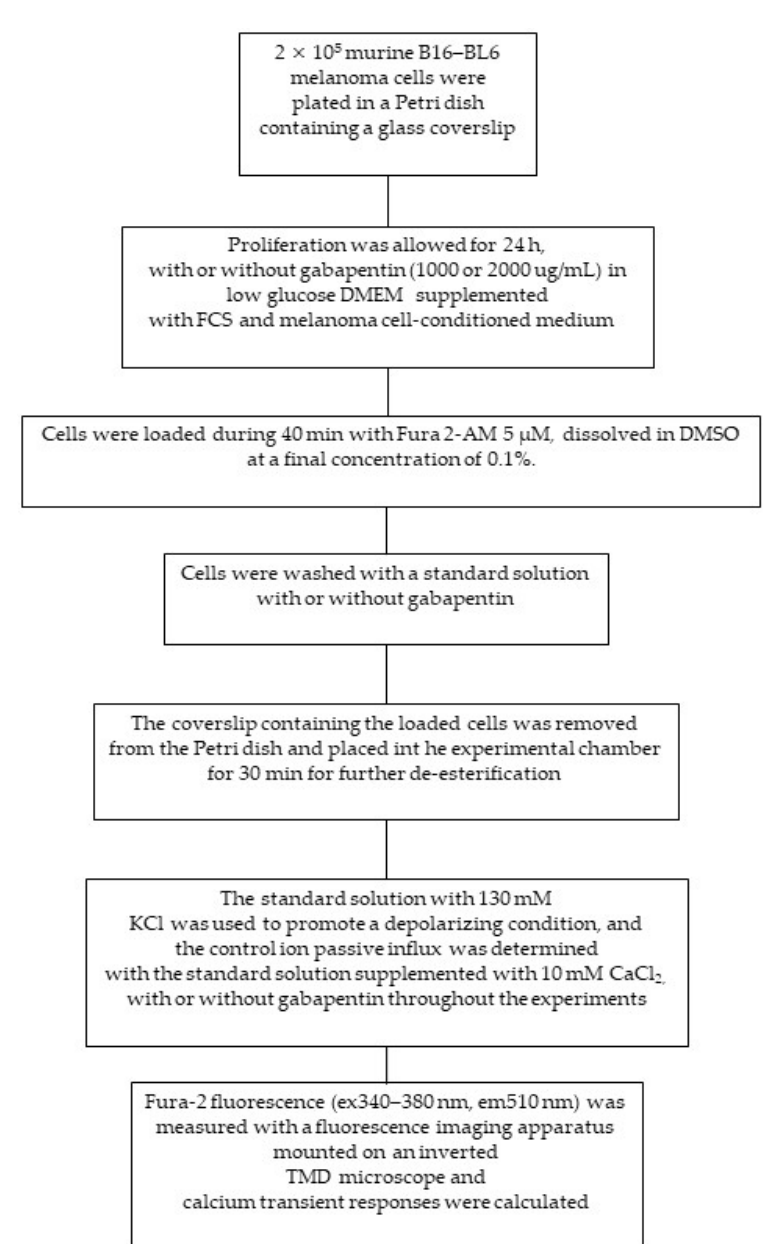
Figure 10. Summary of the in vitro calcium influx experiments.